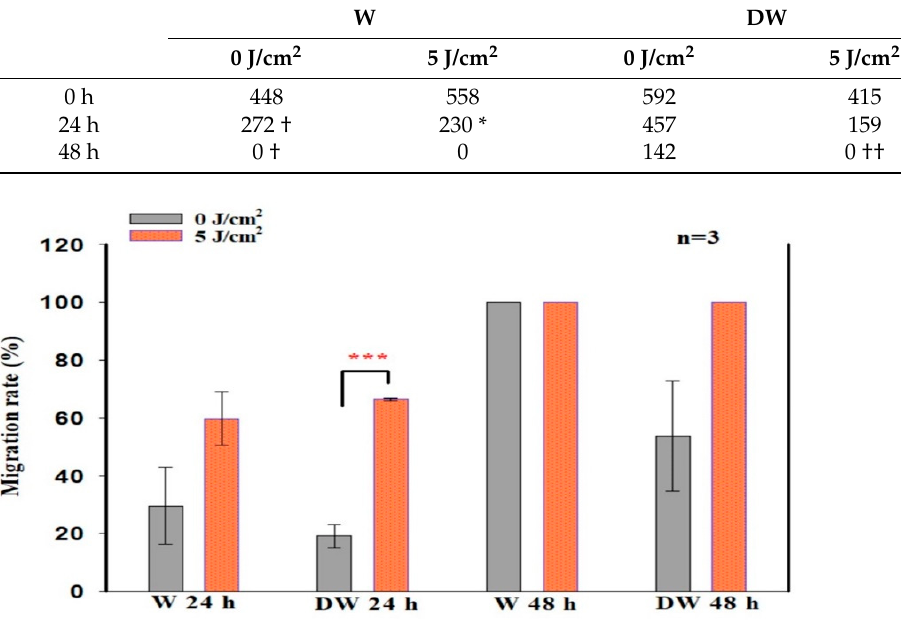
Figure 2. Migration rate (%) in non-irradiated (0 J/cm 2 ) and irradiated (5 J/cm 2 ) wounded (W) and diabetic wounded (DW) cell models, 24 and 48 h following irradiation at a wavelength of 660 nm. Data are expressed as ± SEM (n = 3). Significant probabilities compared to the non-irradiated controls are shown as *** p ≤ 0.001.